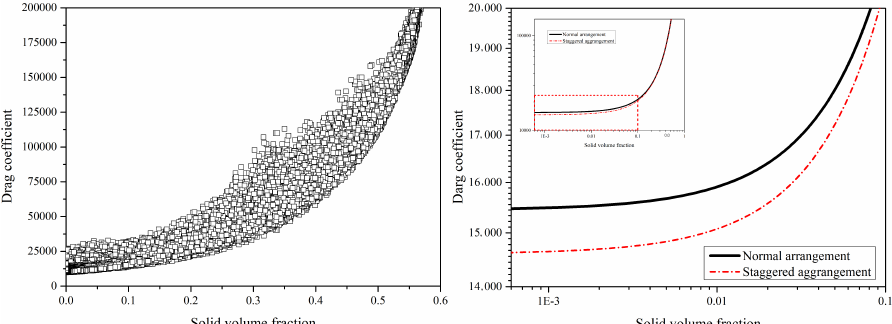
Figure 15. ( Left ): distribution of the drag coefficients for the case with staggered tubes. ( Right ): fitting results of the drag coefficient for different arrangement of